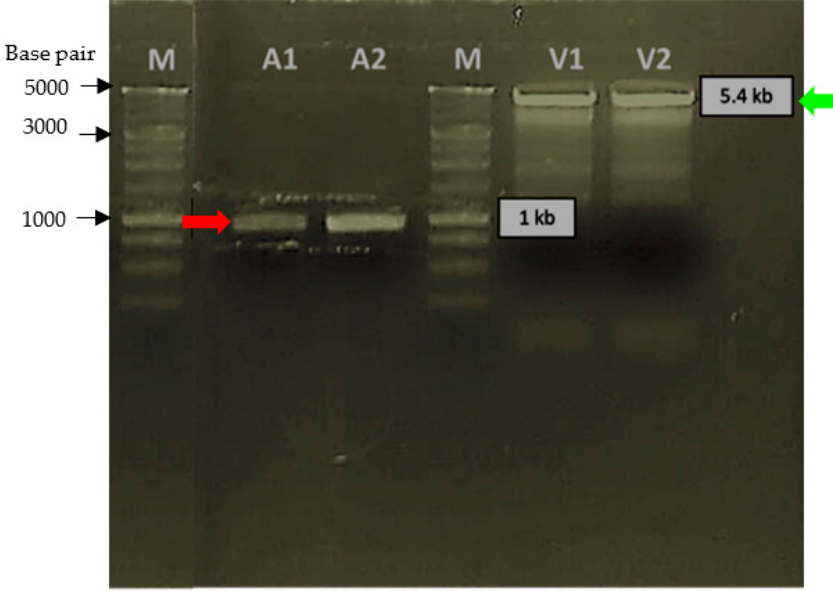
Figure 1. Digestion of PCR product ( Pk -LDH gene) and expression vector pET21a with Nhe I and Xho I. Red arrows showing A1 and A2 lanes were the digested PCR product ( Pk -LDH gene). Green arrows showing V1 and V2 lanes were the digested pET21a expression vector.